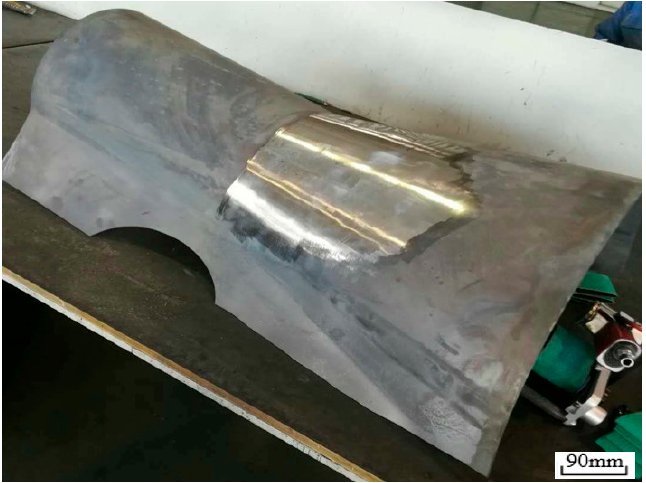
Figure 13. Photo of the final workpiece using the two-step forming scheme.